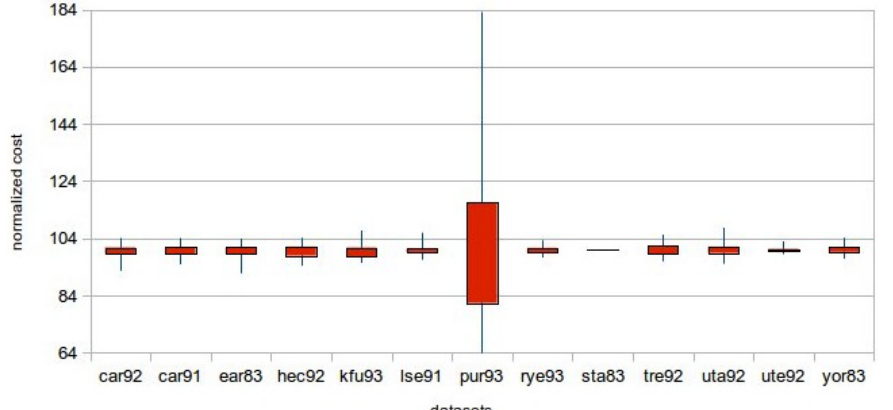
Figure 9. Descriptive statistics chart for a population size of